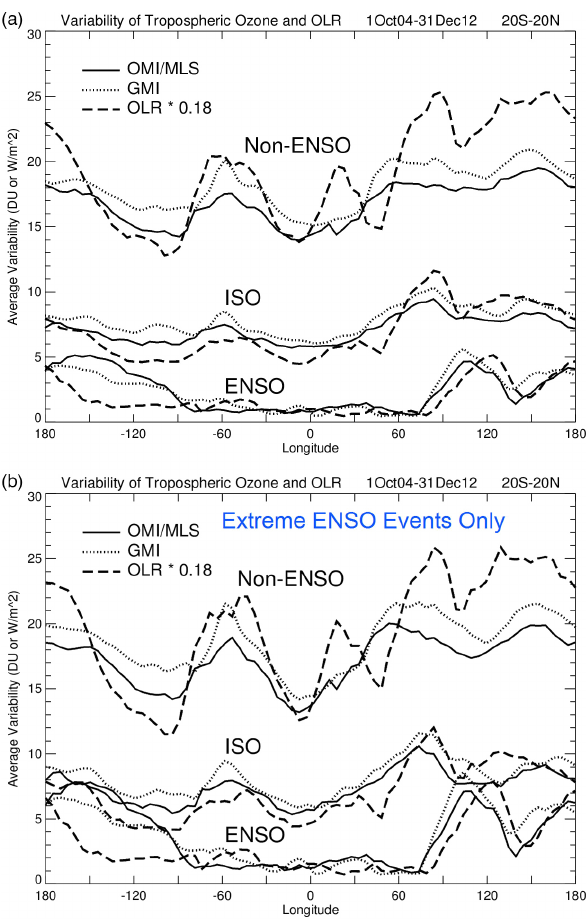
Figure 1. (a) Variability in deseasonalized OMI/MLS daily tropo- spheric column ozone (solid curves), GMI CTM (dotted curves), and OLR (long dashed curves) for ENSO signal, intra-seasonal oscillation (ISO) signals, and with ENSO signals removed (non- ENSO). ISO curves involved band-pass filtering the time series for 25–65-day periods. OLR (units Wm − 2 ) was multiplied by a factor of 0.18 for plotting with ozone. The plotted variability was calculated using amplitude of 2 σ to estimate peak-to-peak change. The time record is 1 October 2004–31 December 2012 and all original time series were averaged over 20 ◦ S–20 ◦ N. The ENSO signals were extracted using the linear regression T (t) = β × Nino34 (t) + ε(t) , where T is original time series, t is day in- dex, β is a derived constant, Nino34 (t) is the Niño 3.4 ENSO index, and ε(t) is the residual that represents the non-ENSO component of the time series. (b) Same as (a) except that all of the time series were filtered for extreme ENSO events whereby Nino34 (t) >1.0 or Nino34 (t) < −